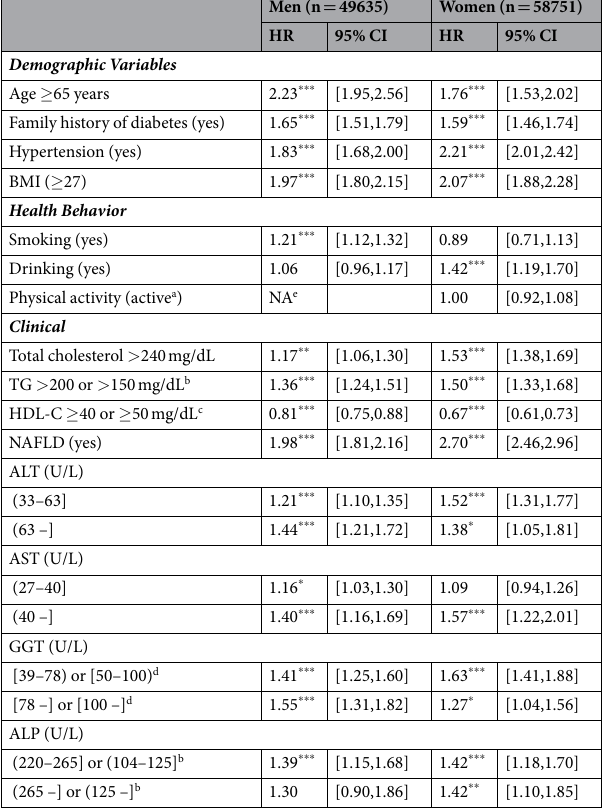
Table 6. Adjusted hazard ratio (HR) of type 2 diabetes in men and women excluding individuals with excessive alcohol consumption or viral hepatitis B (stratification for liver-related enzymes). 95% confidence intervals (CI) in brackets. * p < 0.05, ** p < 0.01, *** p < 0.001. Abbreviations: FPG, fasting plasma glucose; TG, triglycerides; HDL-C, high-density lipoprotein cholesterol; NAFLD, non alcoholic fatty acid disease; ALT, alanine transaminase; AST, aspartate transaminase; GGT, gamma-glutamyltransferase; ALP, alkaline